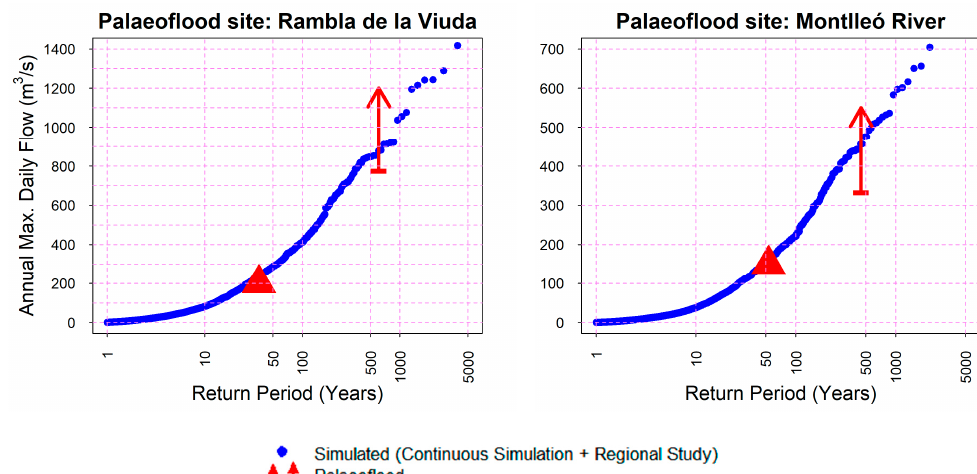
Figure 8. Plotting positions of 10,000 simulated annual maximum daily flows and palaeoflood information used for validation at Rambla de la Viuda and Montlleó River.